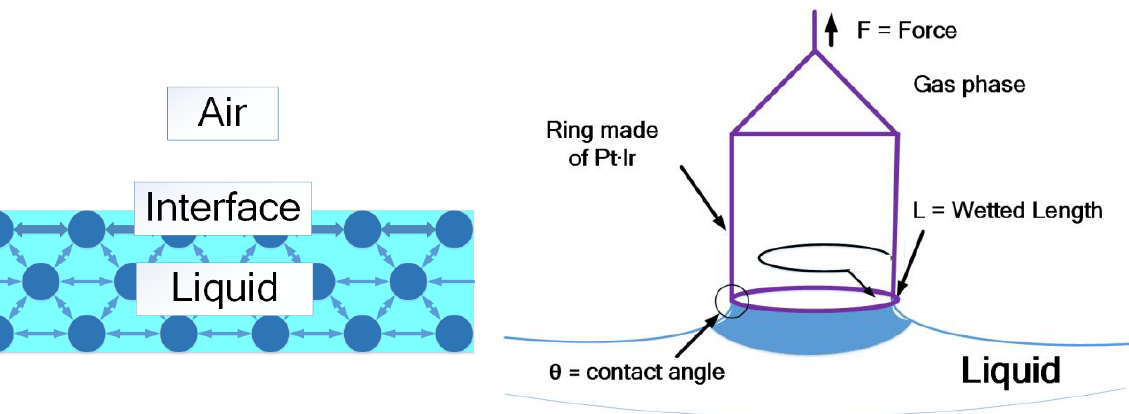
Figure 7. Wettability in terms of contact angle.